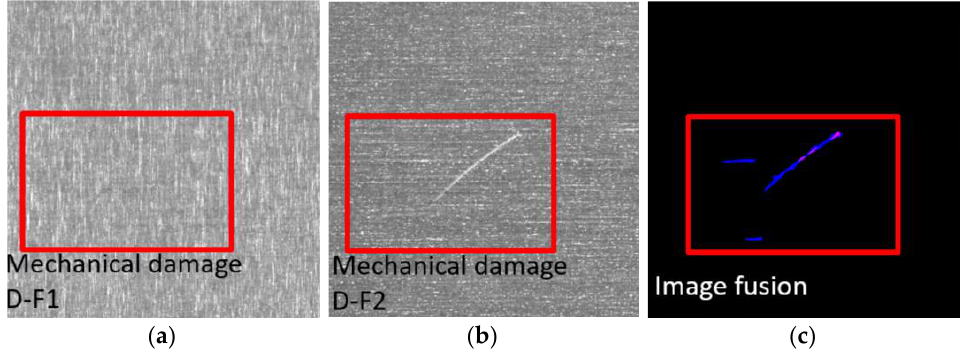
Figure 9. Image fusion in the field of industrial defect detection: ( a ) Image1; ( b ) Image2; ( c ) fusion image (The red box is the area of mechanical damage, which is used to emphasize the obvious fusion effect of the images.)